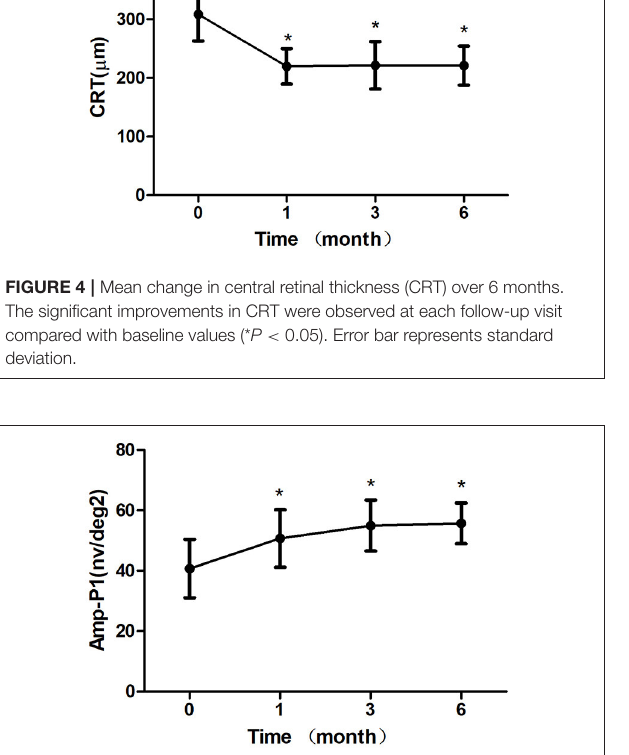
FIGURE 3 | Mean change in best-corrected visual acuity (BCVA) over 6 months. The significant improvements in vision were observed at each followup visit compared with baseline values (* P < 0.05). Error bar represents standard deviation.